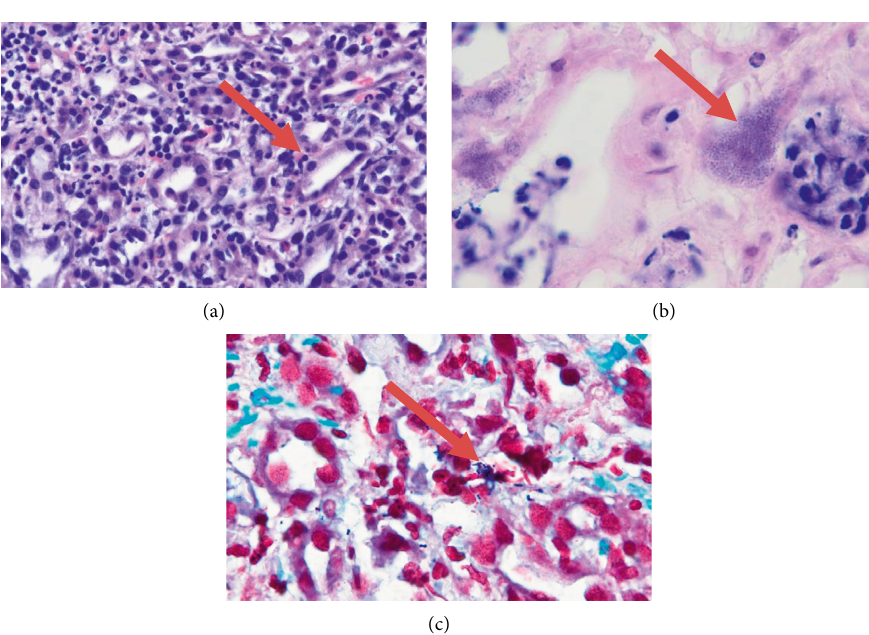
Figure 1: (a) Heavy neutrophil infiltrate in the interstitium with the sparing of the tubular lumen. (b) Clusters of gram-positive cocci in the interstitium. (c) H&E stain showing gram positive cocci in pairs and chains.